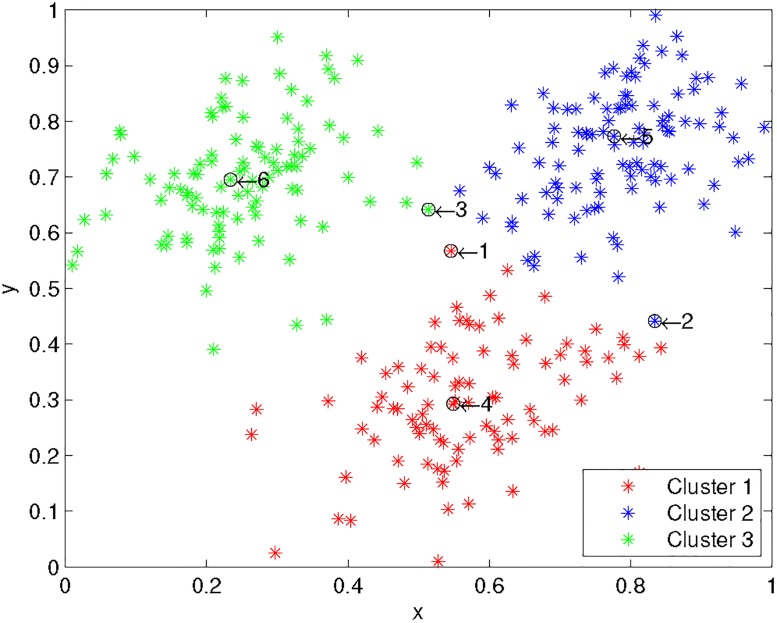
EKM clustering results on 2 dimensional 3 Gaussian clusters.x and y axes denote the first and the second dimension respectively.